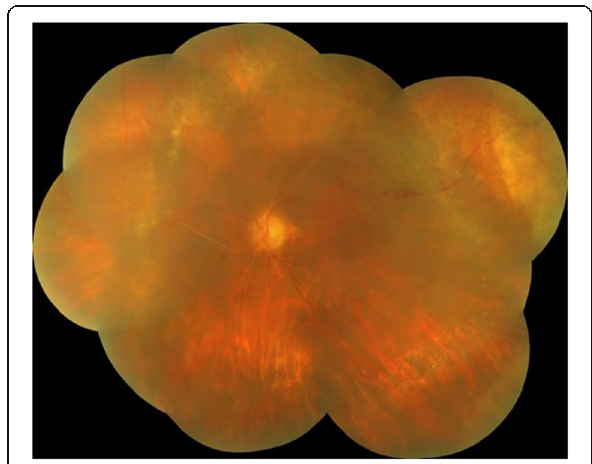
Fig. 6 Color fundus photograph of the left eye showing pallor of the optic nerve head with sclerosed vessels, healed retinitis patches in the periphery, and chorio-retinal atrophy marks due to laser